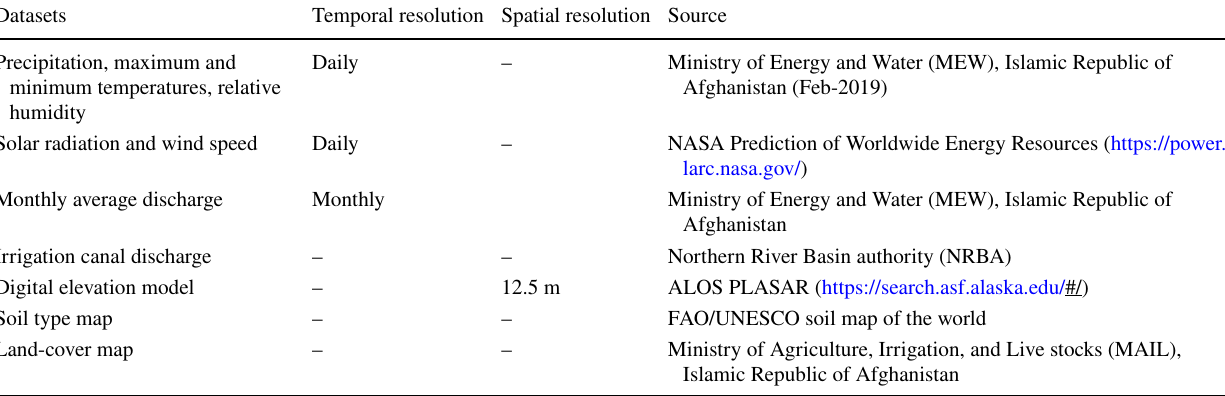
Table 2 Summary of the datasets used in the SWAT modelling